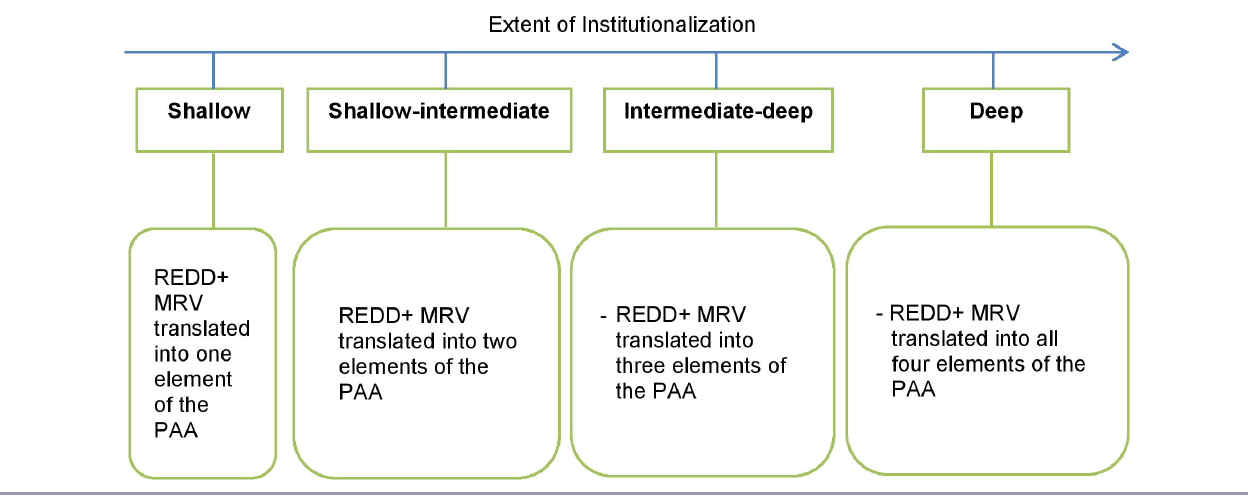
Fig. 1 . A qualitative scale for assessing extent of institutionalization of REDD+ measurement, reporting, and verification (MRV). PAA = policy arrangement approach.